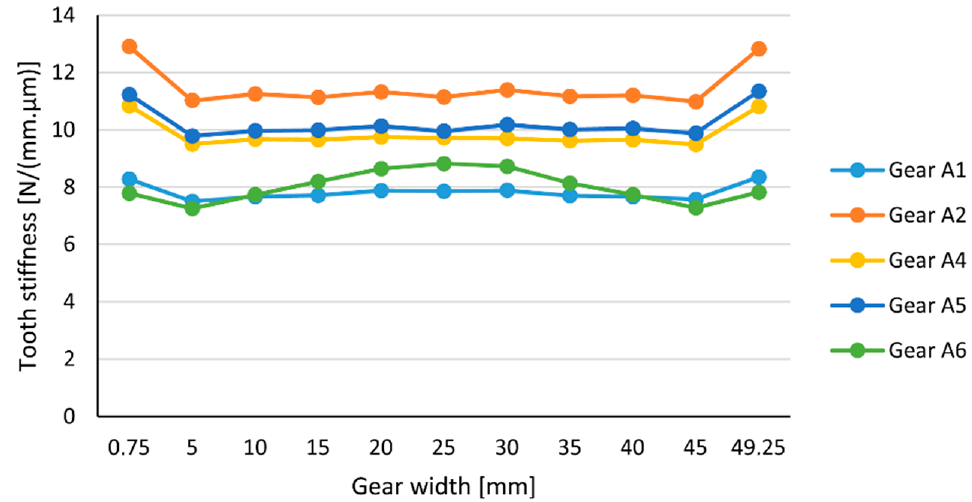
Figure 8. Comparison of gear stiffness across width for forged spur gears.